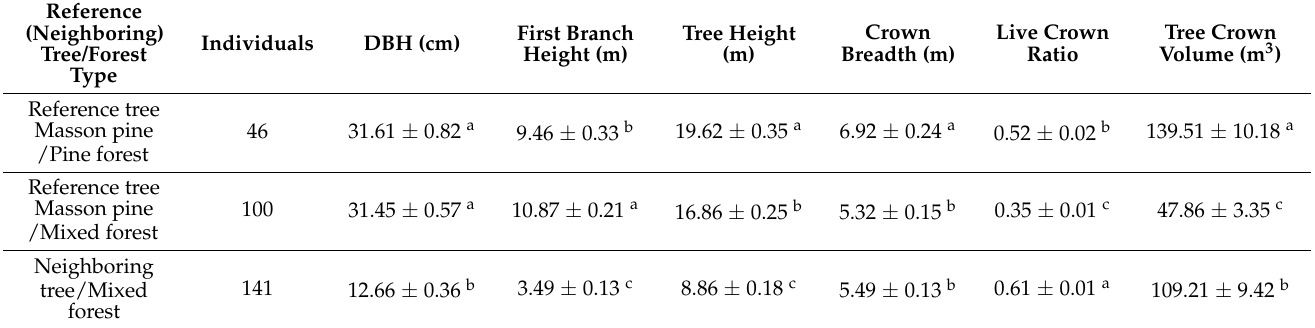
Table 2. Growth performance of Masson pine and broadleaf trees population in pine and mixed forests in southern Jiangsu, eastern China (mean ± SE).